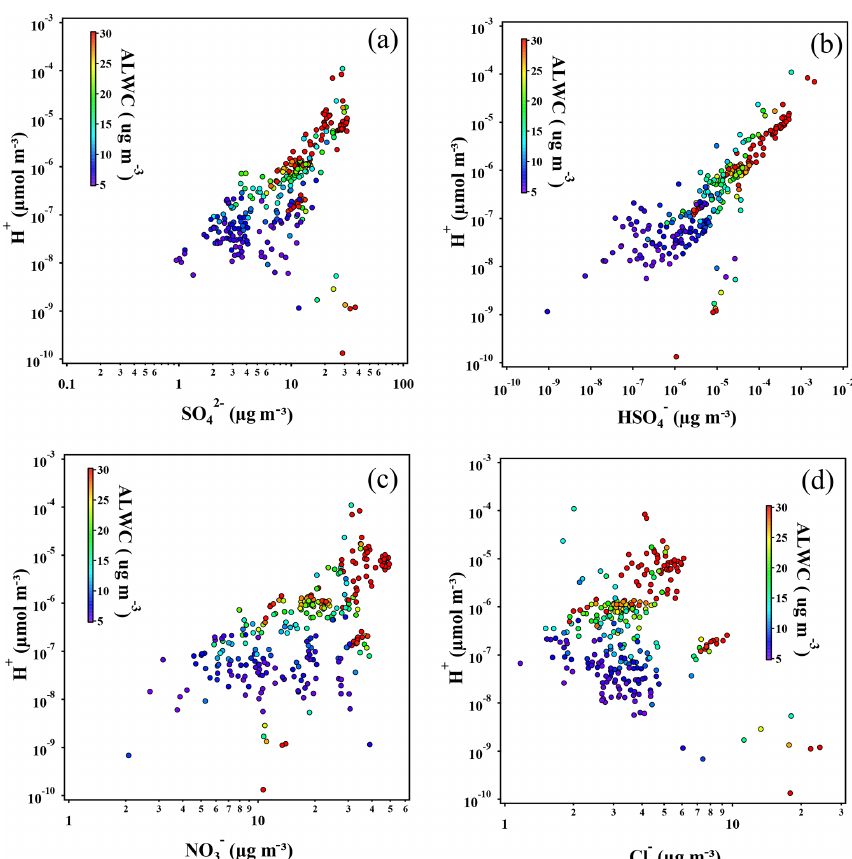
Figure 8. Scatter plots of simulated H + ion vs. major inorganic anions, including (a) SO 2 − are logarithmic. Only the data corresponding to the pollution categories and with sufficient aerosol liquid water (above 5µgm − 3 ) were chosen, and the data during Chinese New Year are